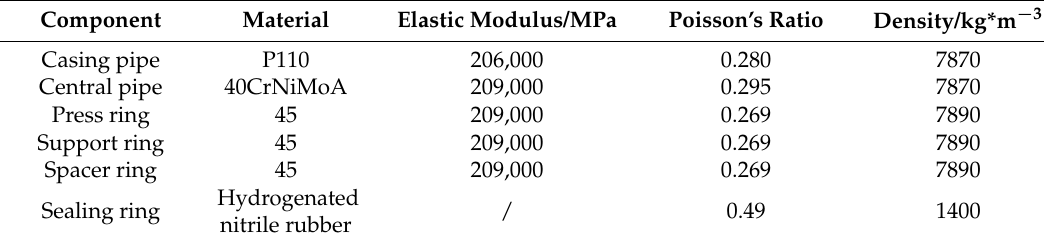
Table 1. Physical